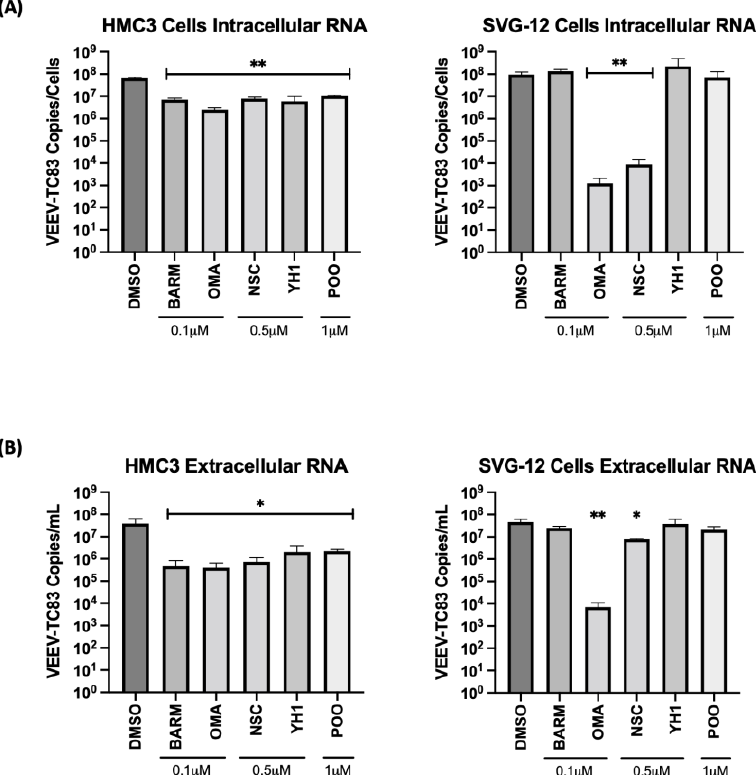
Figure 3. UPS-mediated signaling inhibitors decrease viral RNA in the VEEV-TC83-infected culture supernatants and in infected HMC3 and SVG-p12 cells. HMC3 cells and SVG-p12 cells were seeded in a 96-well plate at a density of 10,000 cells per well. Cells were pre-treated for 1 h with inhibitors or DMSO, followed by an infection with VEEV-TC83 for 1 h. Inhibitor-containing media or the corresponding DMSO control media were added back to cells post-infection and cells were incubated at 37 °C, 5% CO2. Eighteen hours post-infection, supernatants were collected and RNA was isolated for qRT-PCR analysis. Cells were lysed and intracellular RNA was isolated. The viral genomic copy number for VEEV-TC83 in the extracted RNA was quantified by qRT-PCR for ( A ) intracellular RNA and ( B ) extracellular (supernatant) viral RNA quantification. Statistical analysis was performed using One- way ANOVA with Dunnett’s post -test. * p < 0.05, ** p < 0.01.